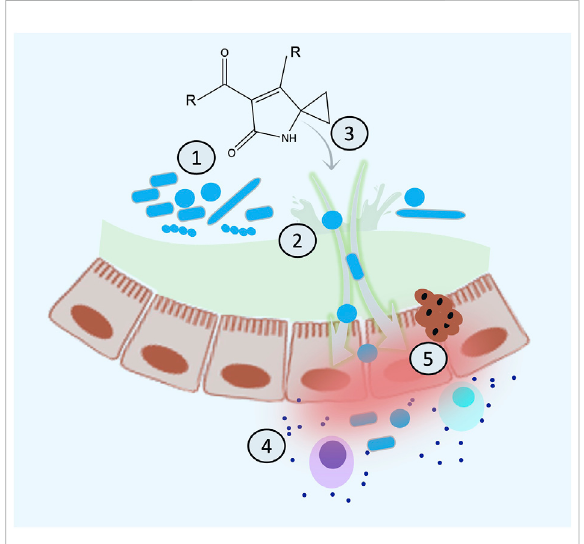
FIGURE 7 Proposed mechanistic model for the sequence of the events of colibactin-induced cancer. (A) Colibactin induces dysbiosis, (B) dysbiosis results in in fl ammation and leaky gut, (C) colibactin diffuses inside the cell resulting in DNA damage, (D) chronic in fl ammation increases the load of colibactin inside the cell and more DNA damage, and (E) accumulating DNA damage leads to